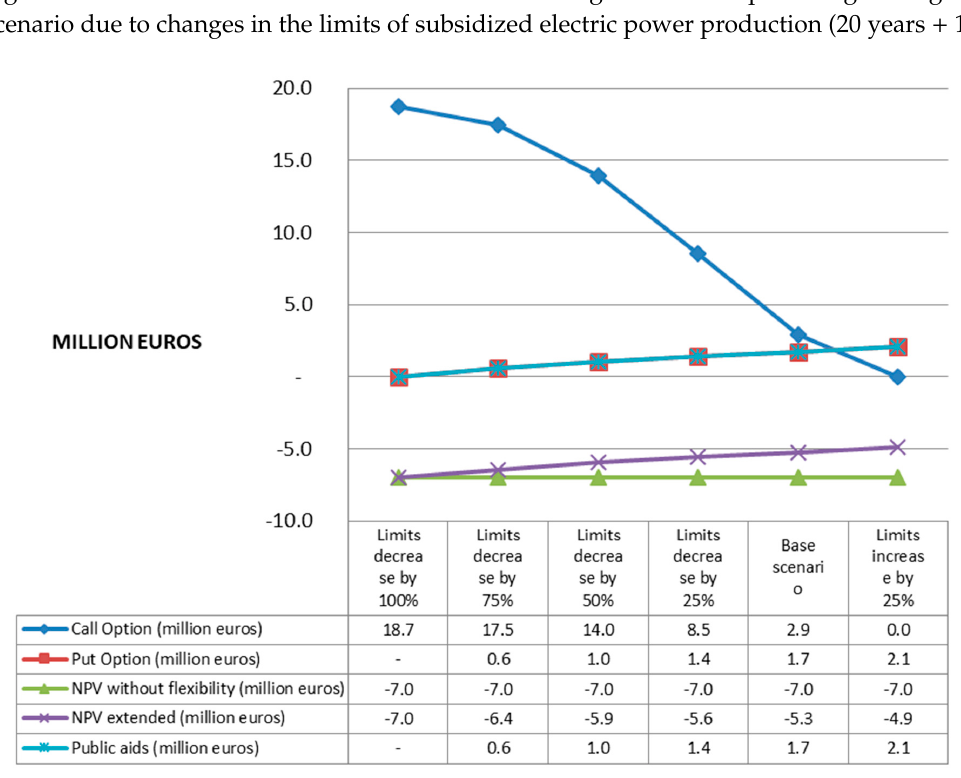
Figure 5. E ff ects of increasing / decreasing the limits (20 years + 1500 h). Source: Own Figure 5. Effects of increasing/decreasing the limits (20 years + 1500 hours). Source: Own elaboration.